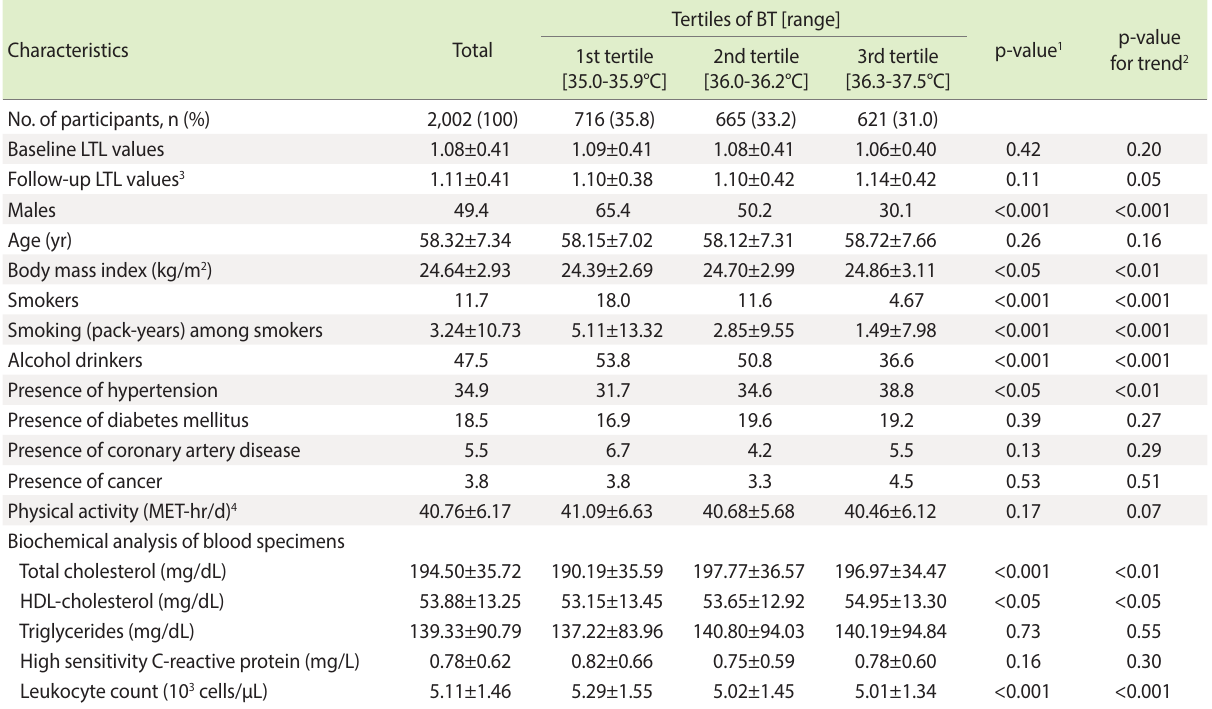
Table 1. Characteristics of the study participants according to the BT tertile